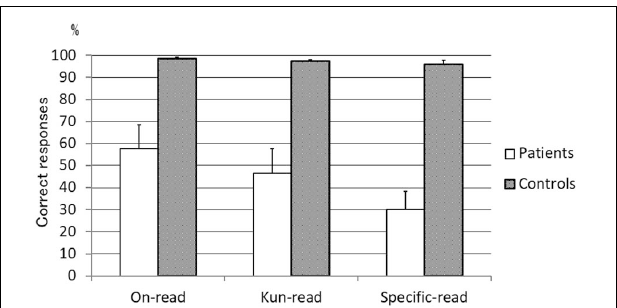
FIGURE 2 | Mean rate of correct responses in the on - kun reading test. Specific-reading was the most impaired, then kun -reading, and on -reading was less impaired ( n = 7). On -reading words = 100 words, Kun -reading words = 100 words, Specific-reading words = 60 words. Error bar denotes standard